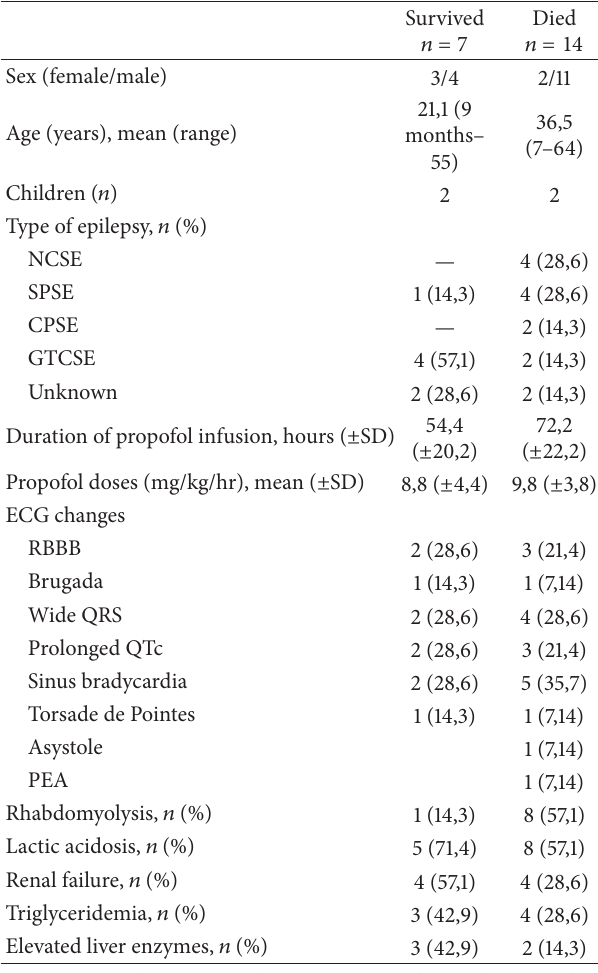
Table 1: Clinical presentation and